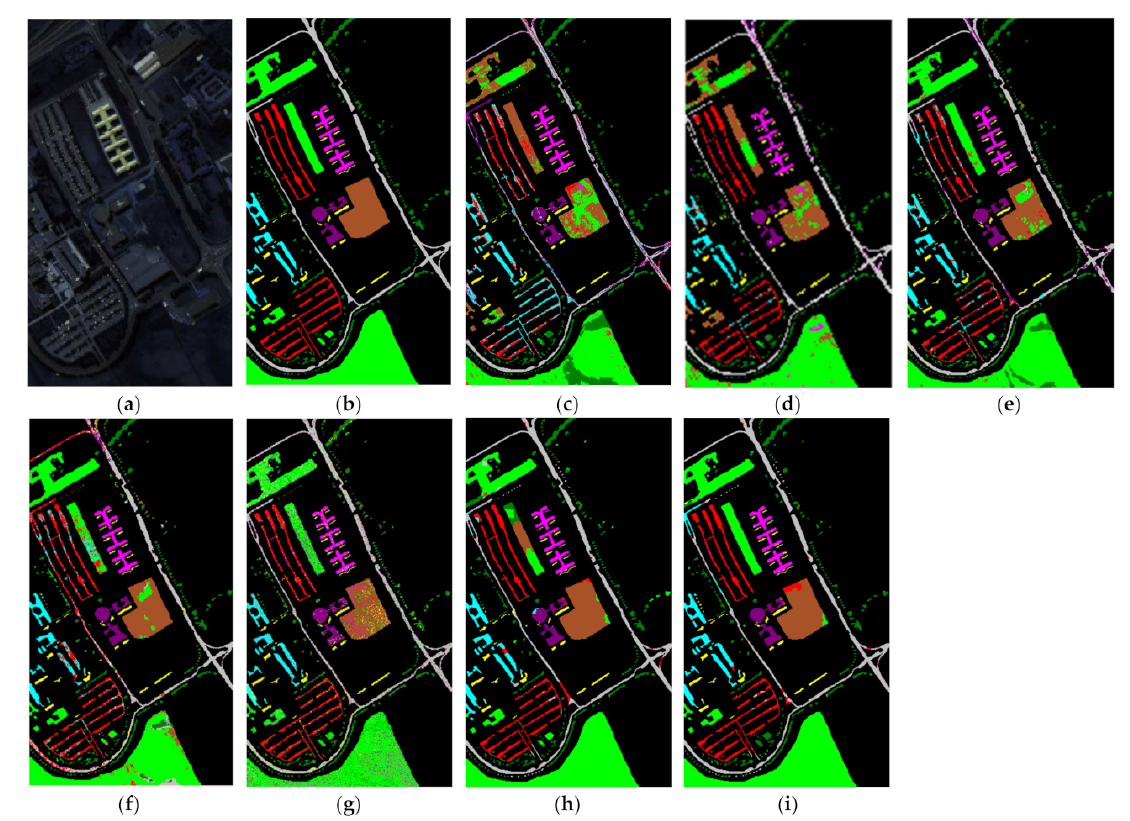
Figure 12. Classification maps obtained by different methods on University of Pavia Dataset.